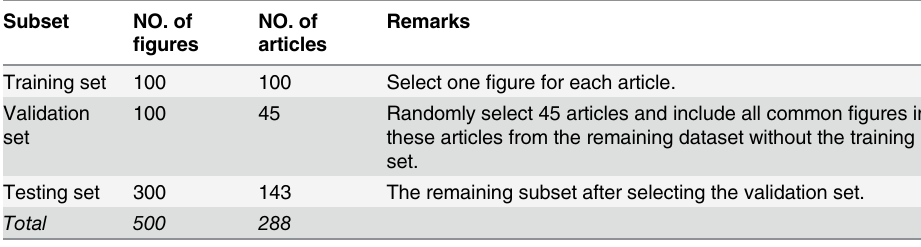
Table 6. Training, validation, and testing sets of D E TEXT.